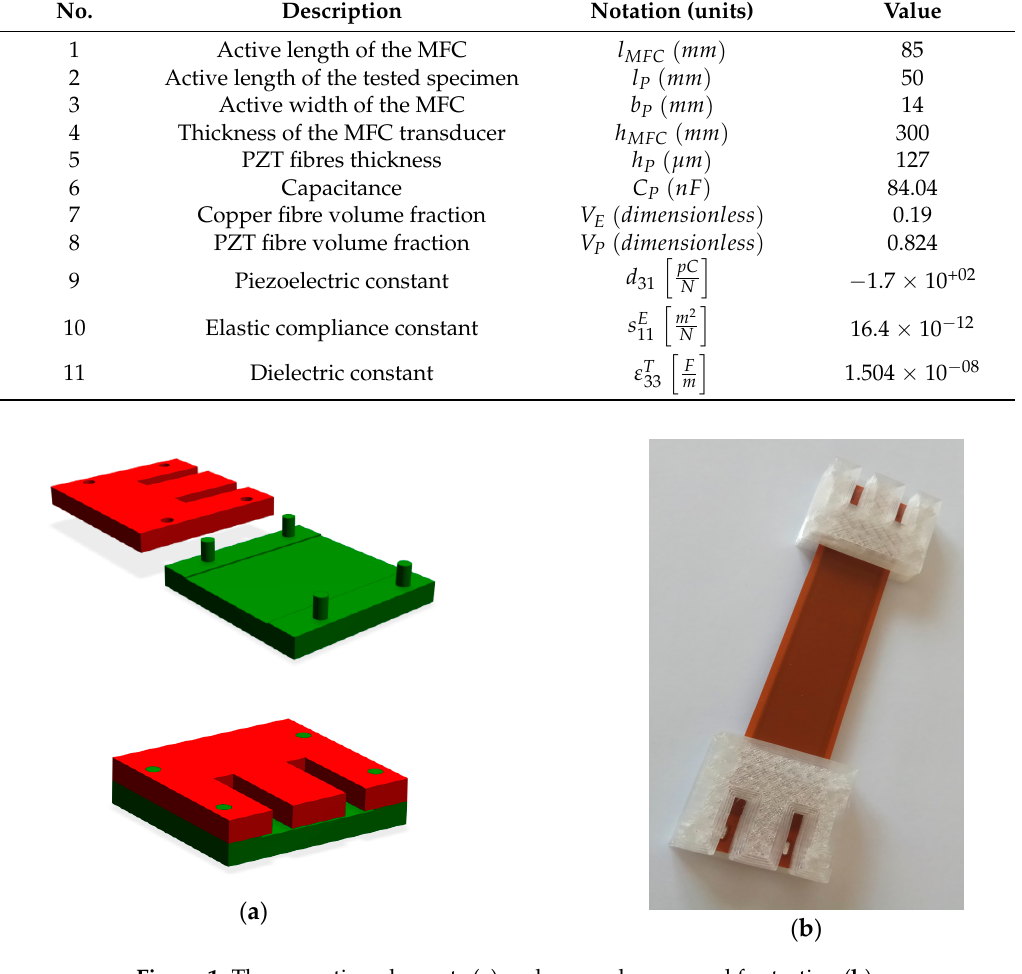
Figure 1. The mounting elements ( a ) and a sample prepared for testing ( b ).